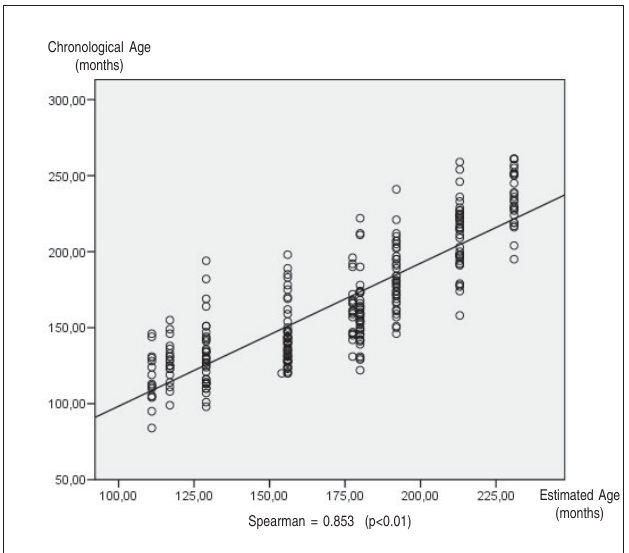
Fig. 1. Linear regression curve correlating estimated and chronological ages. (Upper third molar mineralization evaluation).